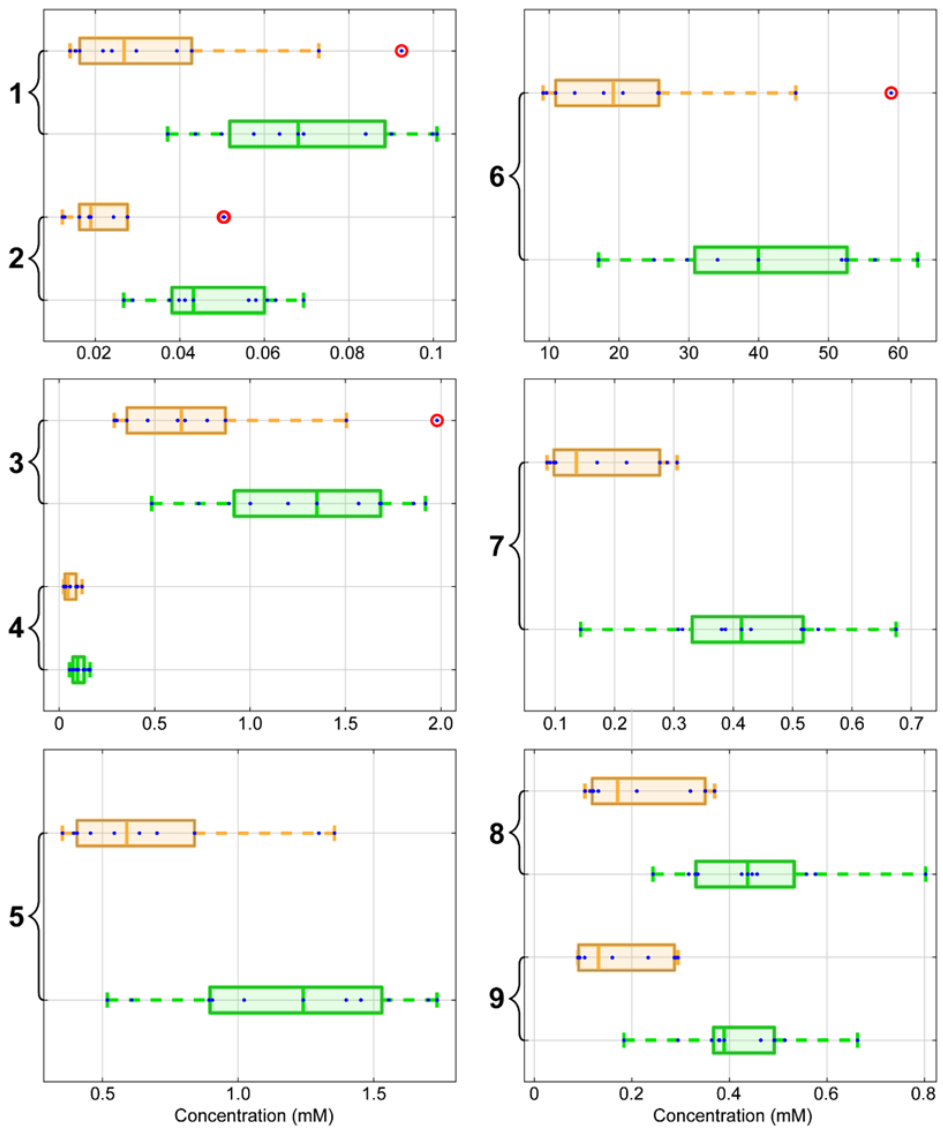
Figure 3. Box plots for the nine metabolites found non-polar extracts from liver of birds from group 1 fed on a high carbohydrate diet (orange) and group 2 fed on a high protein diet (green). The numbers correspond to the peak labels in Figure 2 and Table 2: 1 = glycerophospholipid; 2 = esterified cholesterol; 3 = glycerol backbone; 4 = phosphatidyl choline; 5 = sphingomyelin and choline; 6 = fatty acyl chain; 7 = free cholesterol; 8 = total cholesterol; and 9 = multiple cholesterol protons. The x -axis represents concentration in mM. The vertical line within each box represents the median, and the box limits indicate the first and third percentiles. The difference between the two box limits is the interquartile range or IQR . Data points are represented by blue dots. Suspected outliers (circled in red) lie outside the whiskers shown at 1.5 × IQR above the third quartile and 1.5 × IQR below the first quartile.